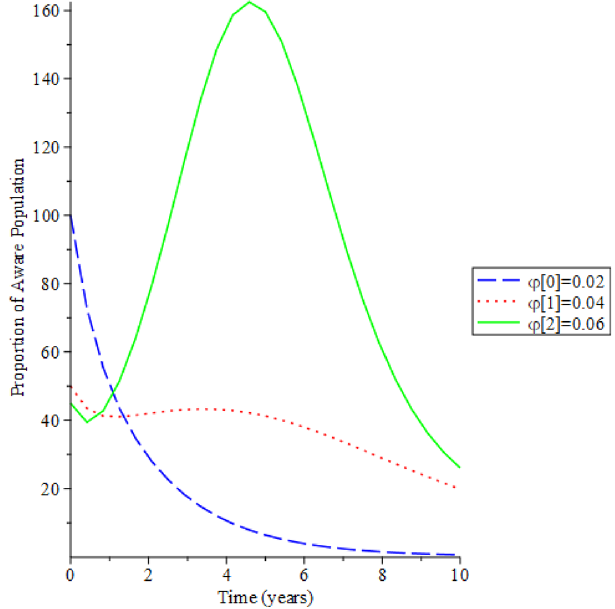
Figure 9. Behavioral dynamics of Infected HIV awareness when varying vertical transmission φ with time.